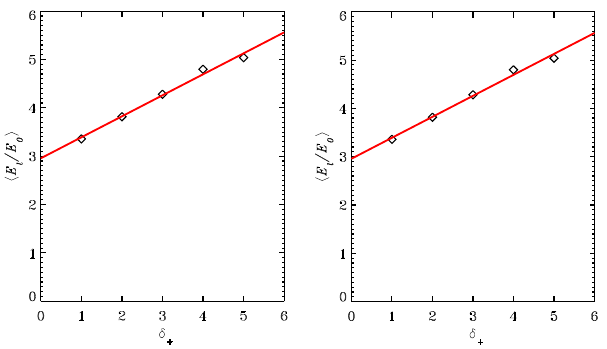
Fig. 3.— Mean value of the lattice energy versus right perturbation amplitude ( δ + ). Best fit obtained by performing linear regression analysis are also shown. On the right the mean value of the energy release versus δ + and the quadratic fit performed.